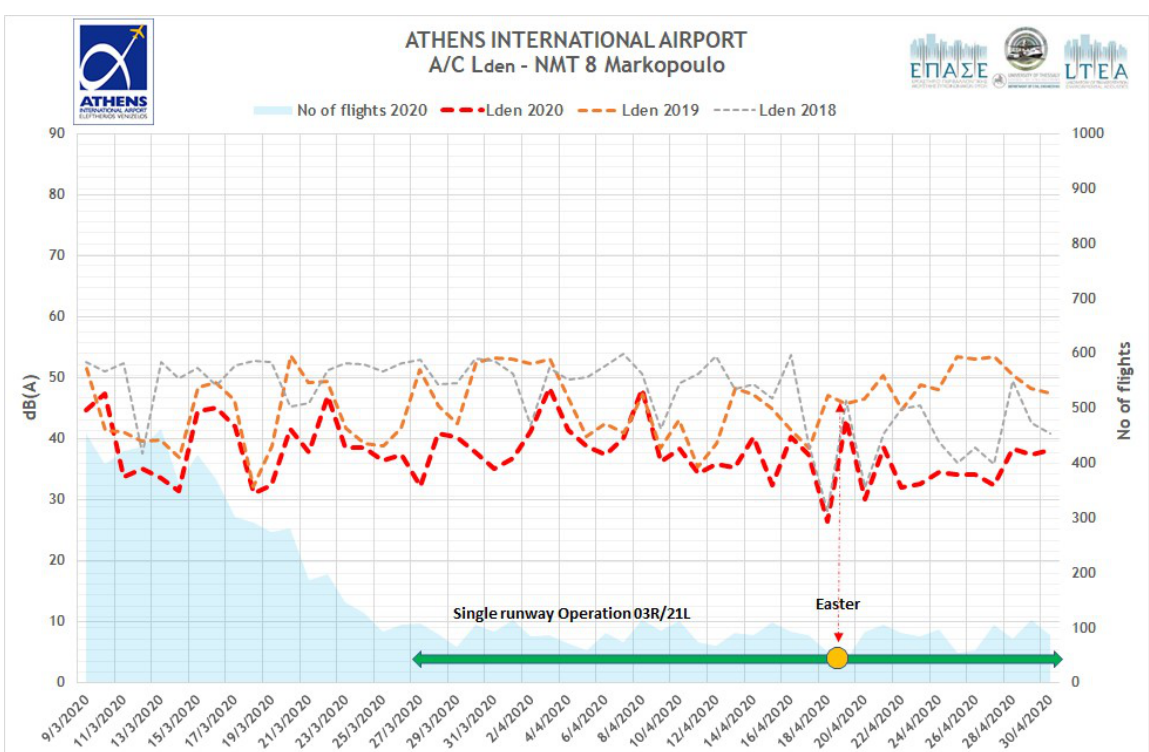
Figure 11f: Fluctuation of L den index - Noise monitoring station NMT 8